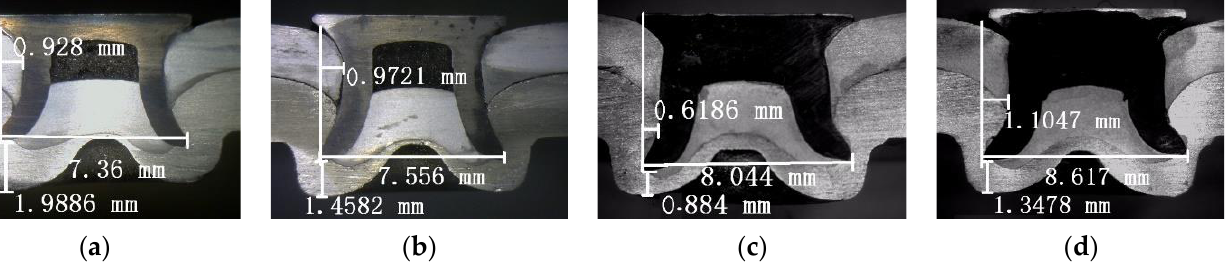
Figure 6. Cross-sectional profiles of SPFC-AA joints at rivet heights of ( a ) 6 mm; ( b ) 7 mm; ( c ) 8 mm; ( d ) 9 mm.